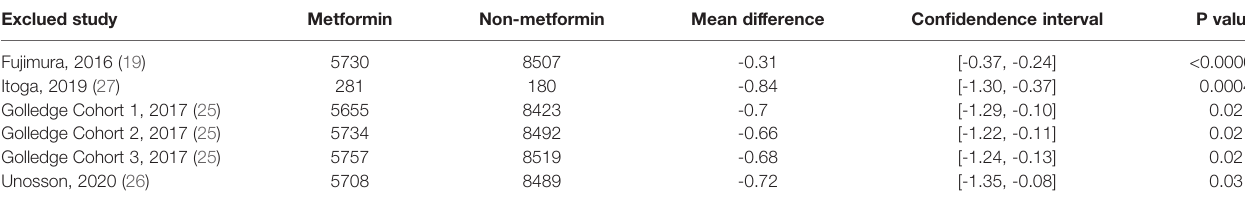
TABLE 3 | Sensitivity analysis results. Exclued study